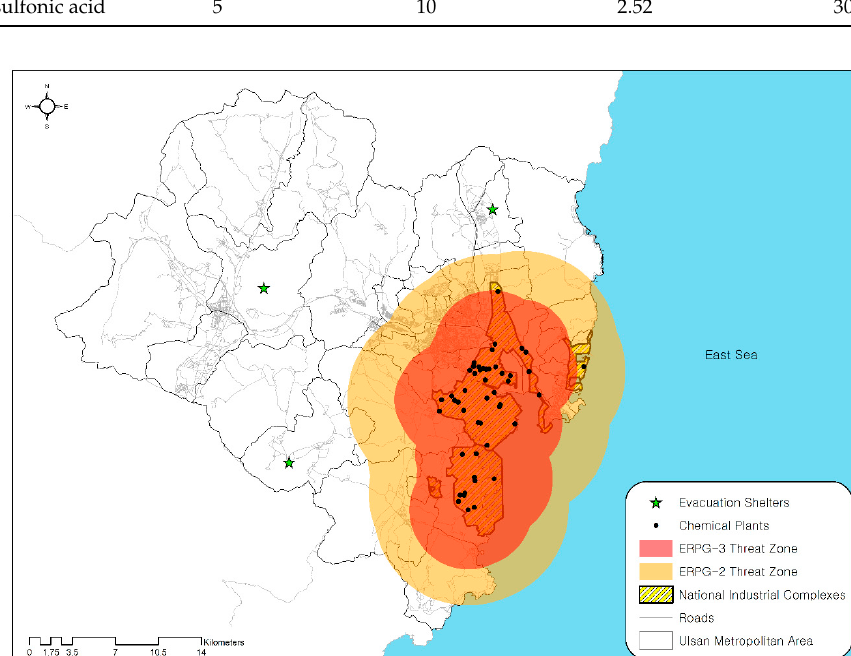
Figure 5. Example of identified ERPG threat zones in ALOHA.